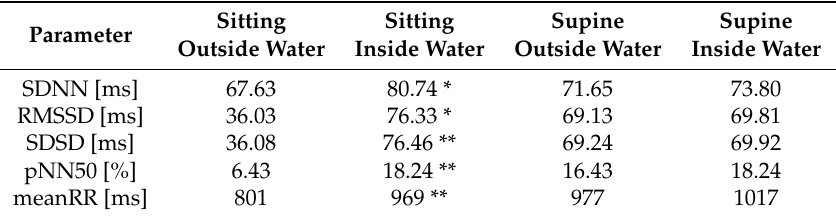
RMSSD = root mean square of successive differences. SDSD = standard deviation of successive differences. pNN50 = percentage of the number of adjacent RR intervals which differ more than 50